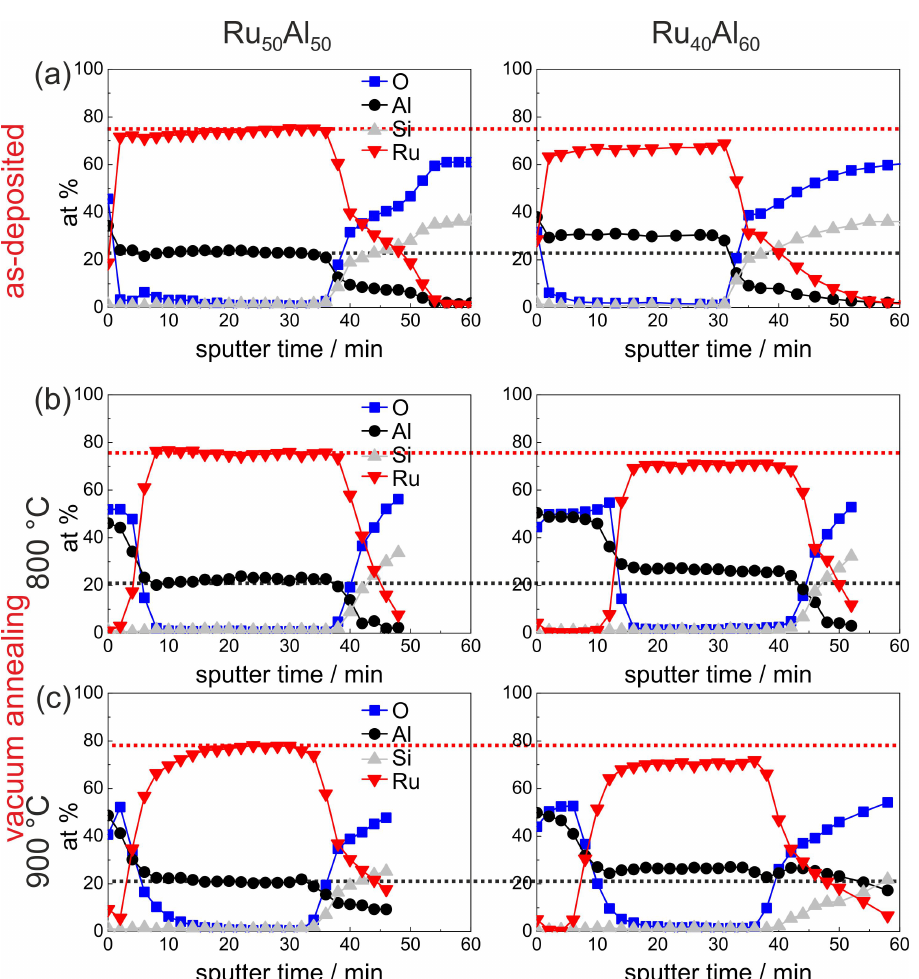
Figure 5. AES measurements of the Ru 50 Al 50 and Ru 40 Al 60 samples in ( a ) the as-deposited state and after annealing for 10 h in high vacuum at ( b ) 800 ◦ C and ( c ) 900 ◦ C. The red (black) dotted line marks the Ru (Al) content of the as-deposited reference Ru 50 Al 50 sample to visualize the difference to the other